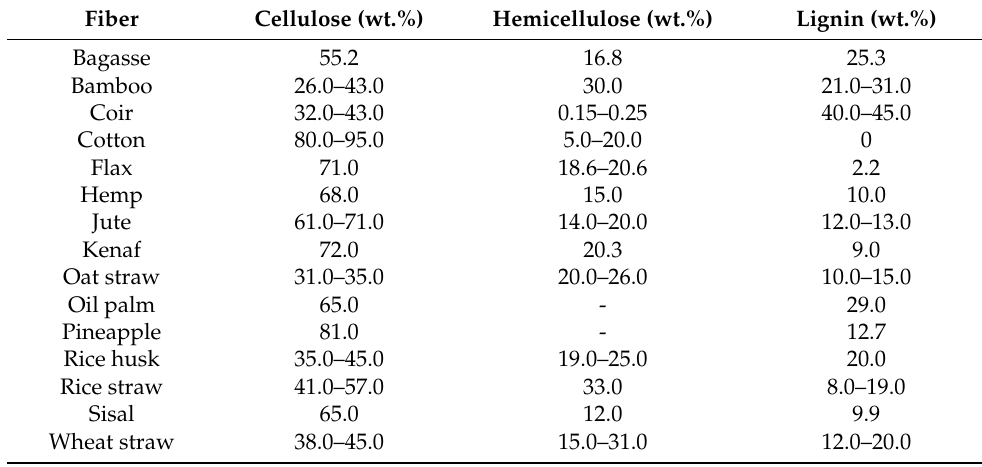
Table 1. Chemical composition of typical natural fibers